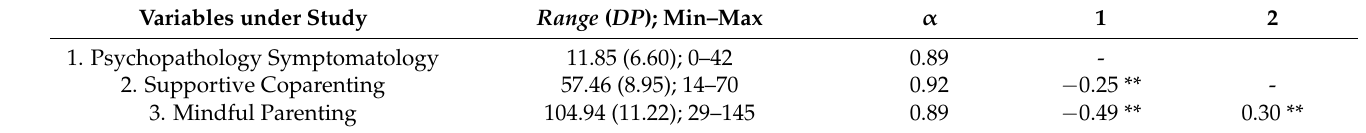
Table 2. Descriptive Statistics and Correlations between the Variables Under